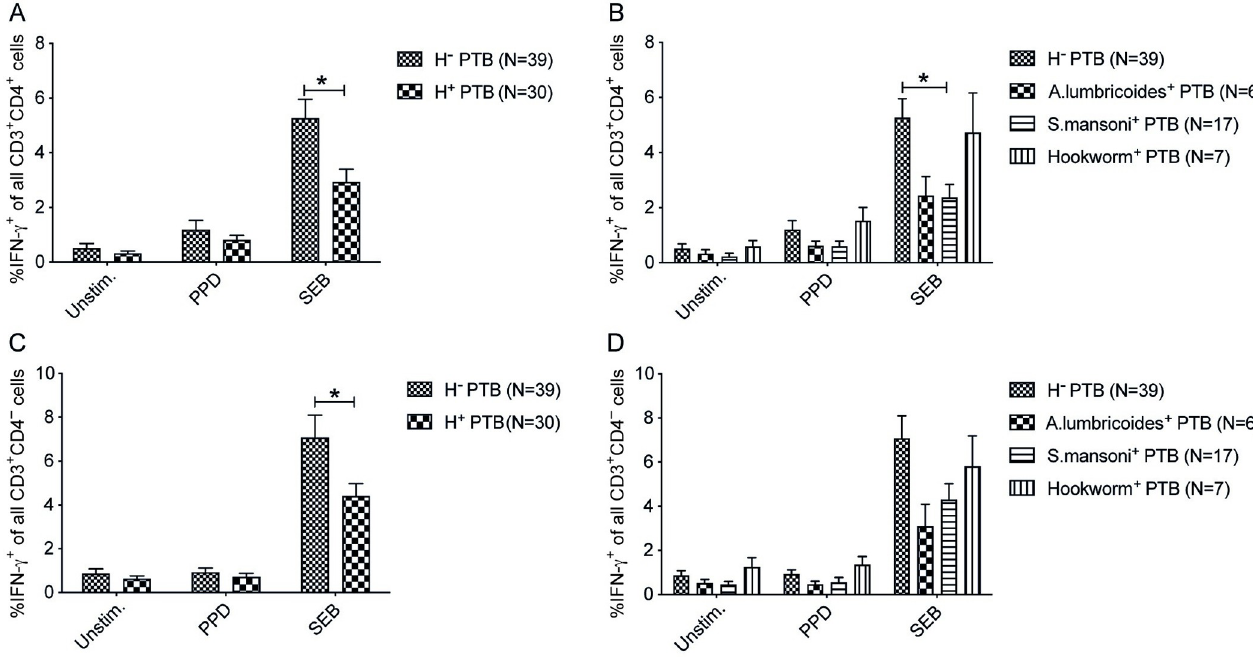
Fig 4. Decreased IFN- γ production by CD3 + T cells in pulmonary TB patients with S . mansoni coinfection. Unstimulated, PPD and SEB stimulated PBMCs of PTB patients were incubated with Brefeldin A ex vivo to analyze intracellular IFN- γ expression in CD3 + CD4 + and CD3 + CD4 - T cells by flow cytometry. Frequency of IFN- γ + CD4 + T cells in helminth negative PTB (H - PTB) and combined A . lumbricoides , S . mansoni and worm positive PTB patients (H + PTB) (A), and H - PTB versus specific helminth infection (B). Frequency of IFN- γ + CD4 - T cells of all CD3 + CD4 - cells in H - PTB and combined H + PTB (C), and specific helminths in PTB patients (D). Data presented as mean ± SEM and the unpaired two-sided Student’s t-test was used to analyze the differences between H - PTB and H + PTB whereas one-way ANOVA followed by Tukey’s multiple comparison test was used to assess the species specific effects. � , p < 0.05.